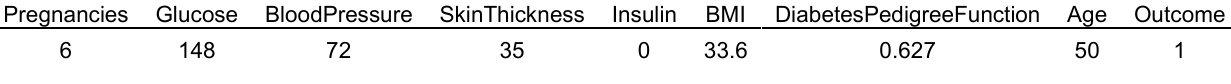
Table 1. Diabetes Data